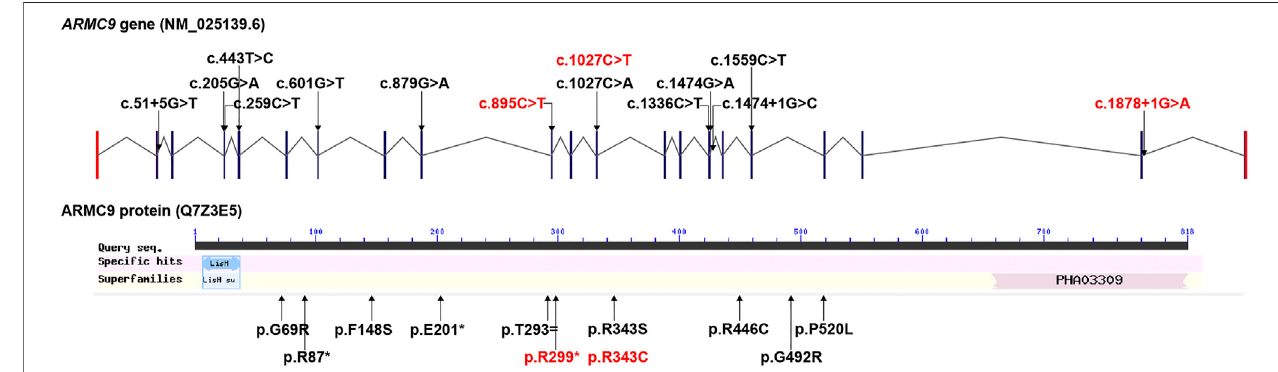
FIGURE 2 | All ARMC9 variants associated with the JS phenotype reported in the literature, illustrated in gene and protein schematics (red fonts represent the variants in this